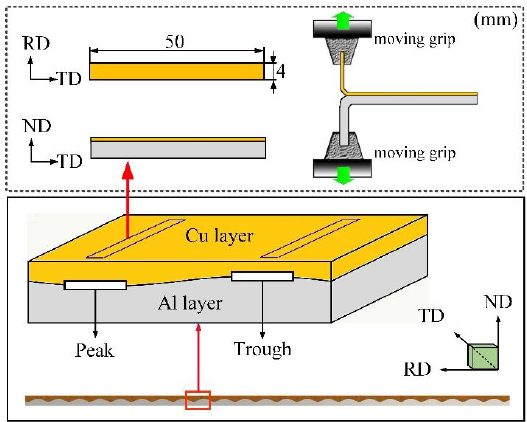
Figure 2. The positions and specifications of the peel test samples.